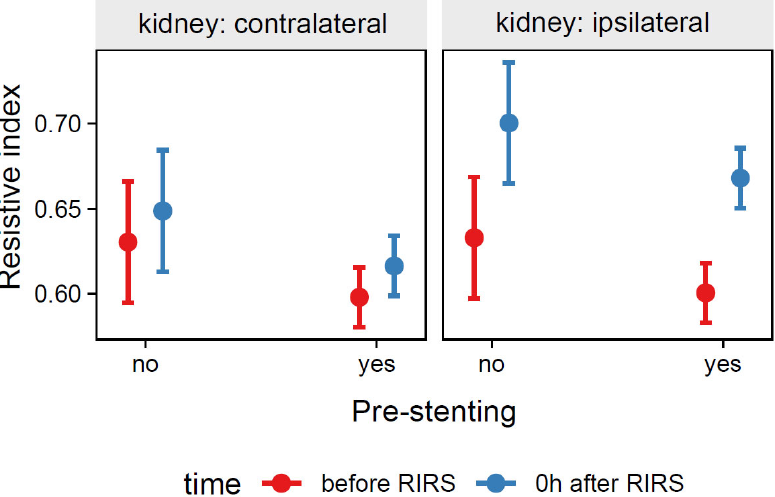
Figure 4. Predicted values (marginal effects) of resistive index by the Mod3 regression model for pre-stenting, time, and kidney side terms.